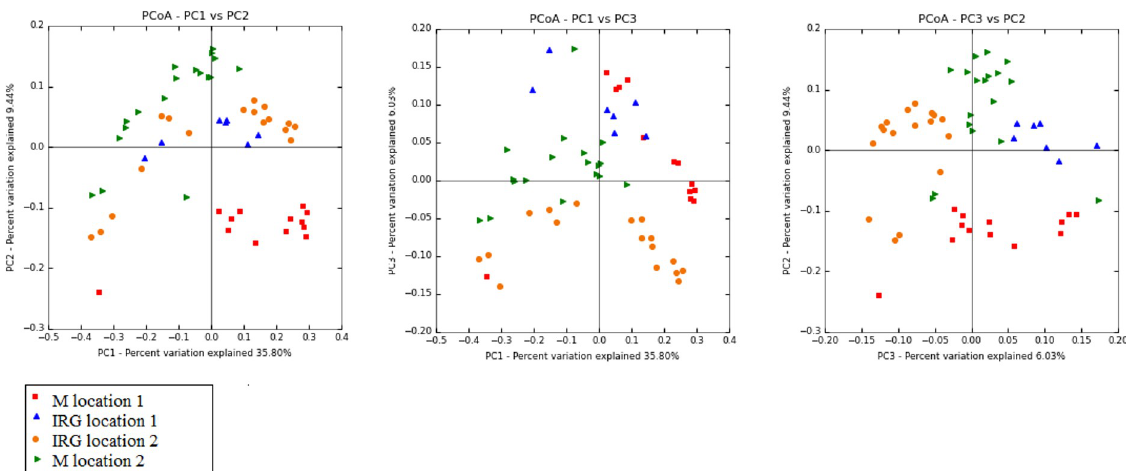
Fig 9. Beta diversity of the four different hays PCoA loadings plots of unweighted unifrac (M1 n = 3, M2 n = 3, IRG 1 n = 1, IRG2 n = 3). It is clear that meadow 1 is different to the other hays.